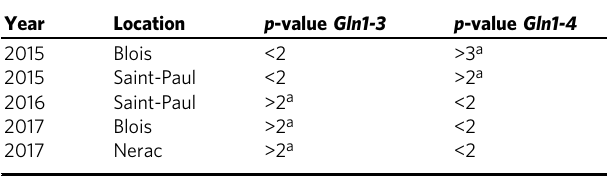
markers was 0.17 on 352 DHILs of the panel and the allele of the two genotypes AA and BB at a given marker) was 3.82